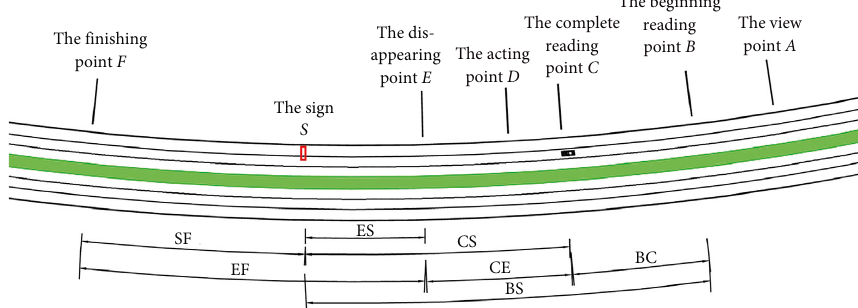
Figure 2: The traffic sign recognizing process on the curved highway (for details, refer to the